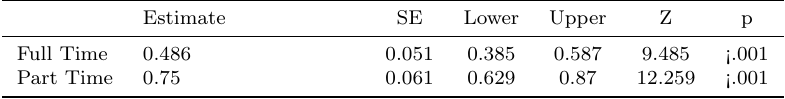
Table 4: Conditional Effects of Predictor at Levels of Work